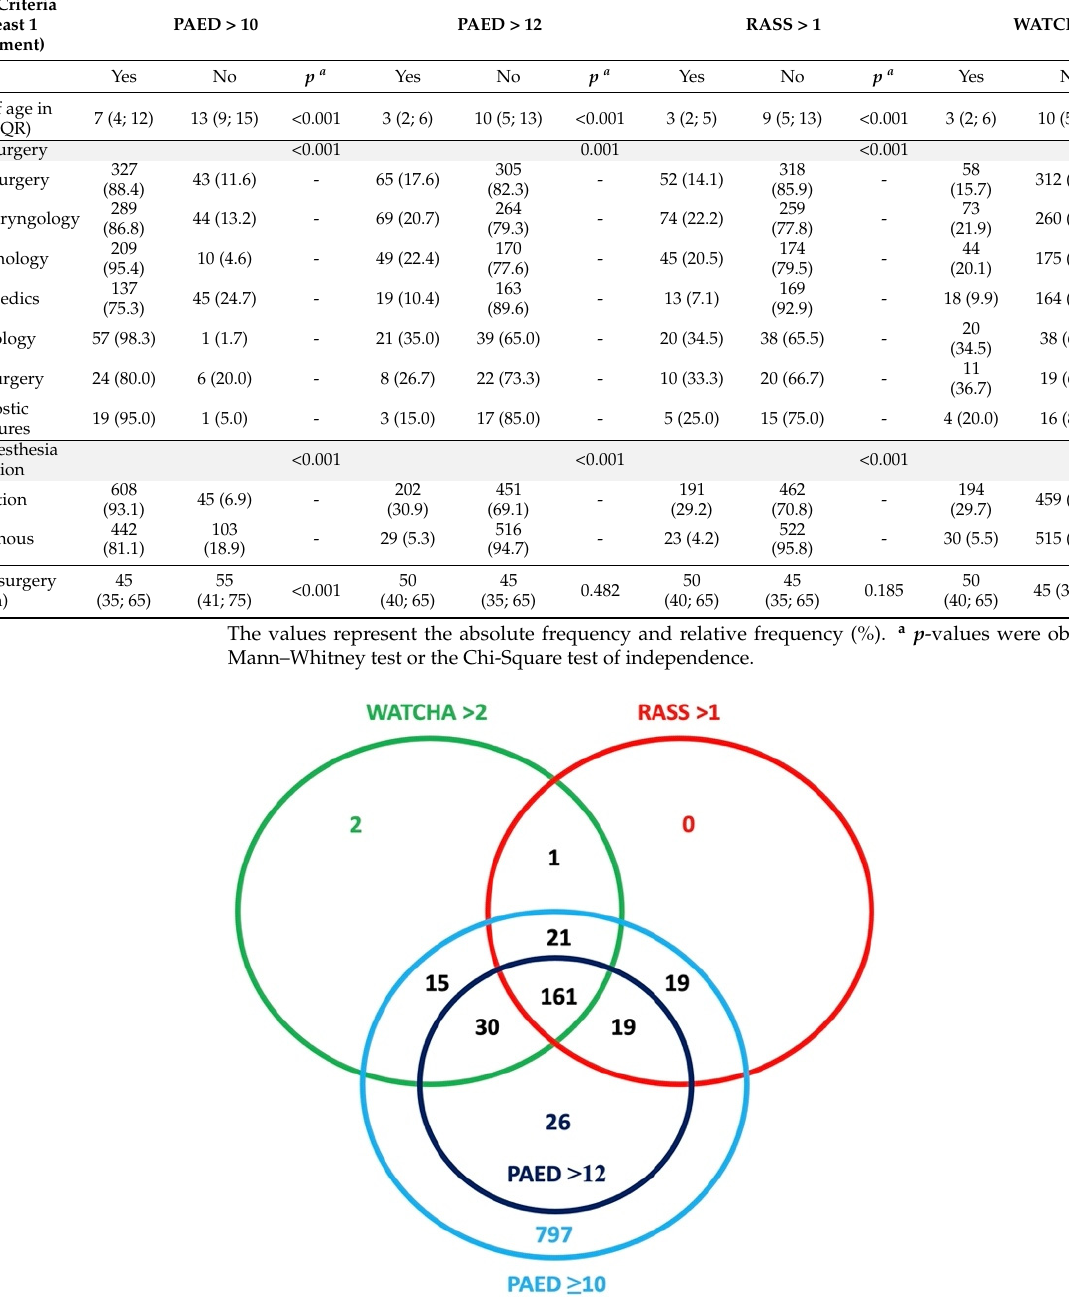
Table 2. Emergence Delirium (in at least 1 measurement).